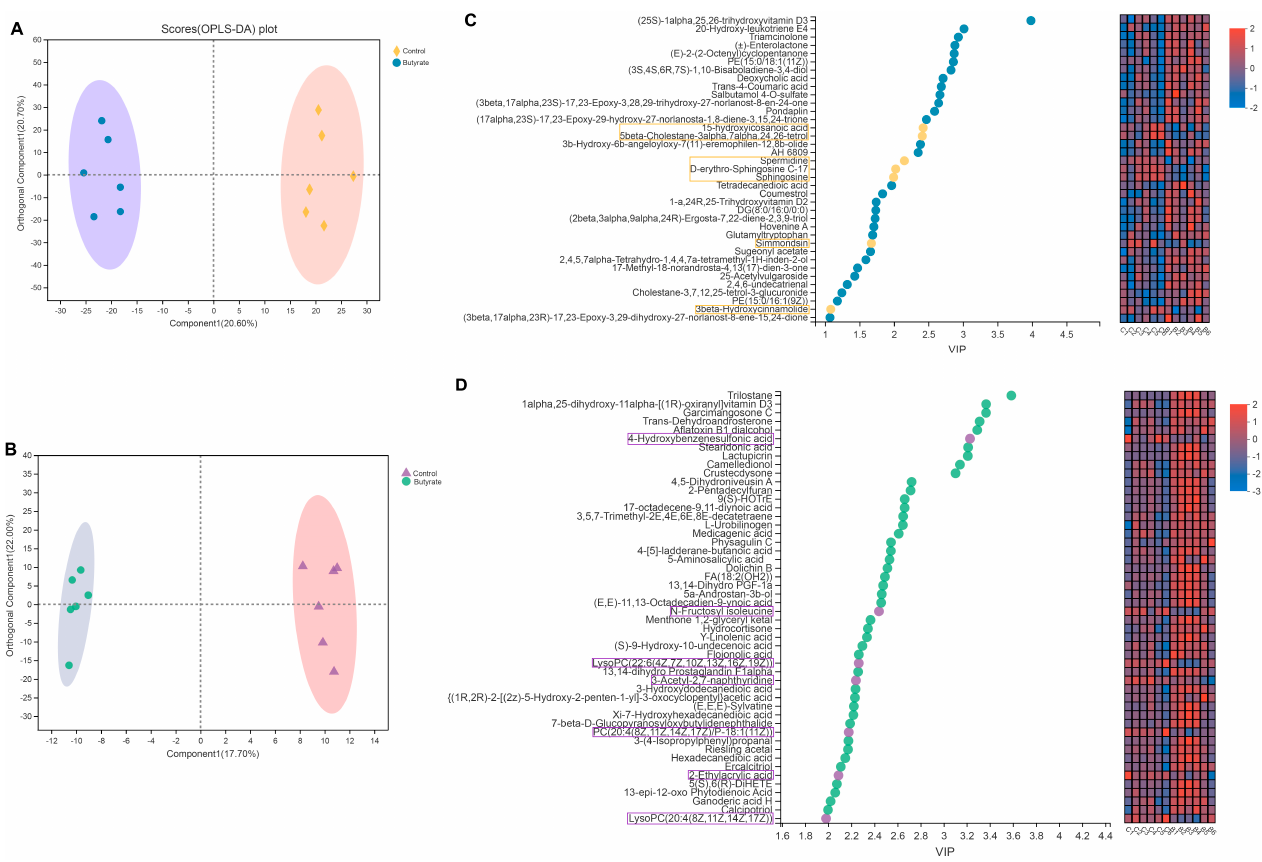
Figure 5. Differential analysis of metabolites between the control and butyrate groups in the ileum metabolome and plasma metabolome of weanling rabbits. ( A ) PLS–DA analysis of the ileal metabolome. ( B ) PLS–DA analysis of the plasma metabolome. ( C ) Analysis of the VIP values of the ileum metabolome. ( D ) Analysis of the VIP values of the plasma metabolome. VIP ≥ 1. The metabolites inside the yellow box in Figure C are the differentially dominant metabolites in the control group in the ileum; outside the yellow box are the differentially dominant metabolites in the butyrate group in the ileum. Metabolites inside the purple box in Figure D are the differentially dominant metabolites in the control group in plasma; outside the purple box are the differentially dominant metabolites in the butyrate group in